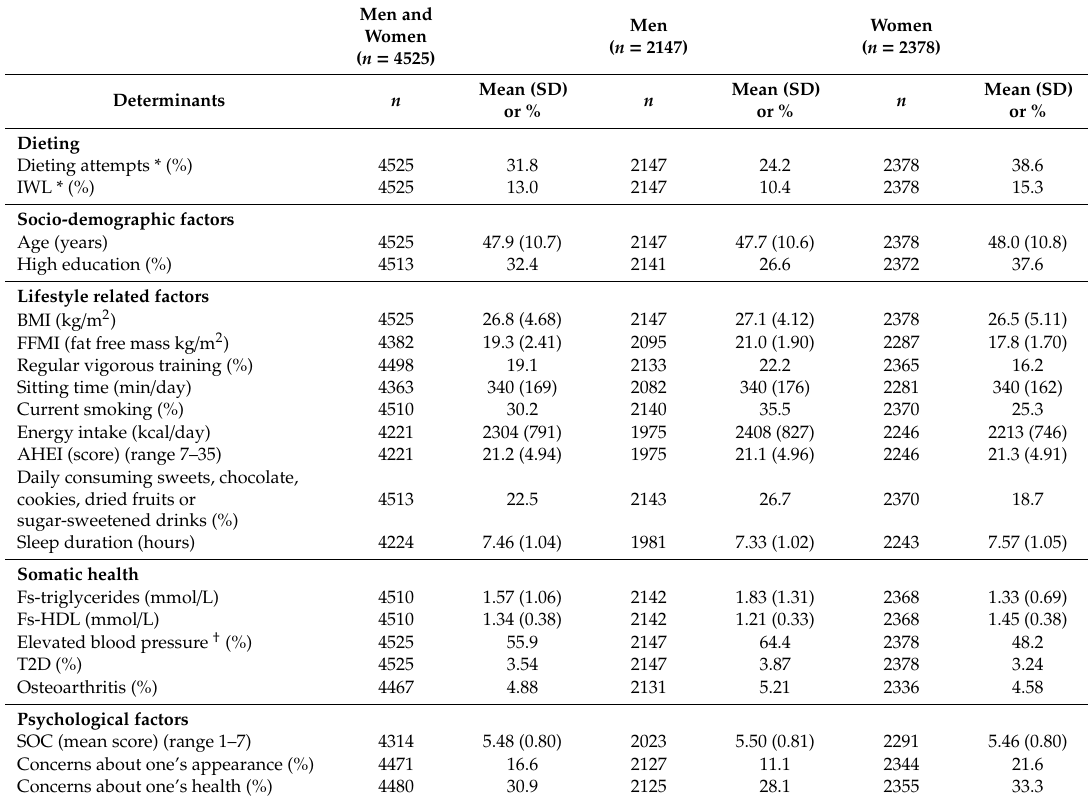
Table 1. Characteristics of the men and women in the study